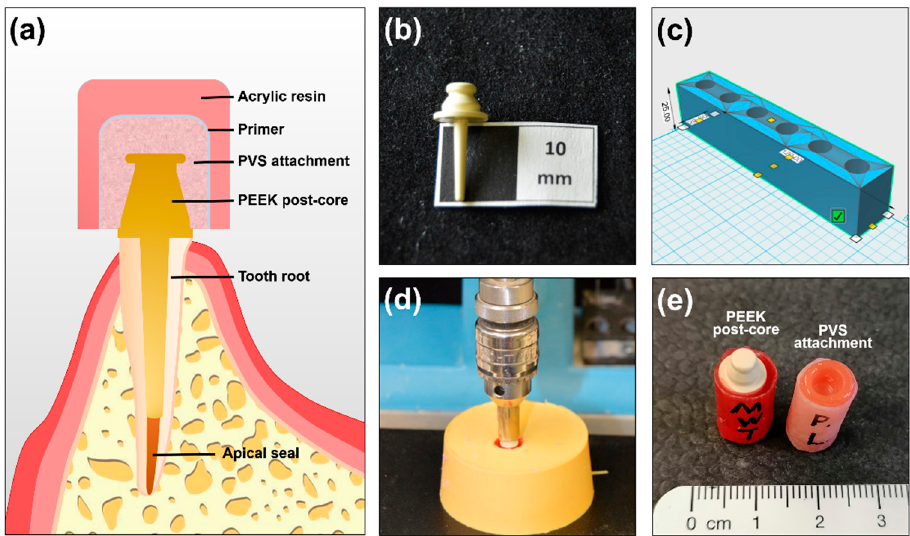
Figure 1. Experimental specimens used in the study. ( a ) Simplified schematic design of a novel polyetheretherketone (PEEK) post-core restoration with a polyvinylsiloxane (PVS) attachment system; ( b ) PEEK post-core restoration; ( c ) a holding device designed by computer-aided design; ( d ) insertion using a parallel guidance device; ( e ) tested specimens (left: a PEEK post-core restoration, right: a PVS attachment).